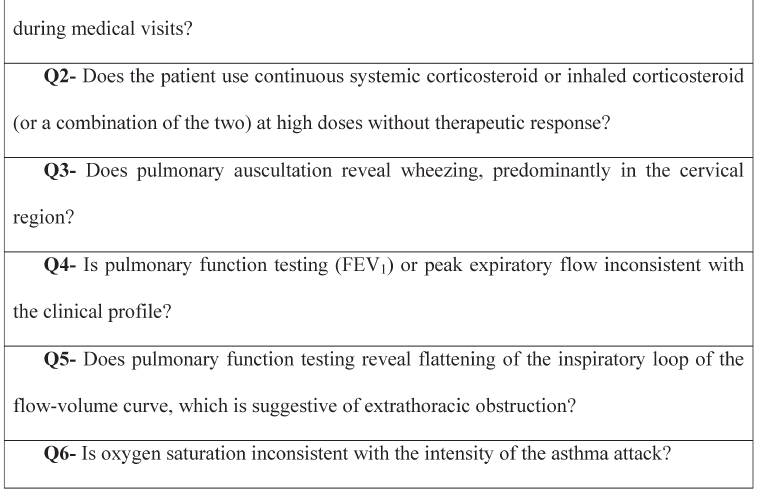
Figure 11 - Specific questionnaire for the clinical suspicion of vocal cord dysfunction. Q: question;FEV 1 : forced expiratory volume in one second; and PEF: peak expiratory